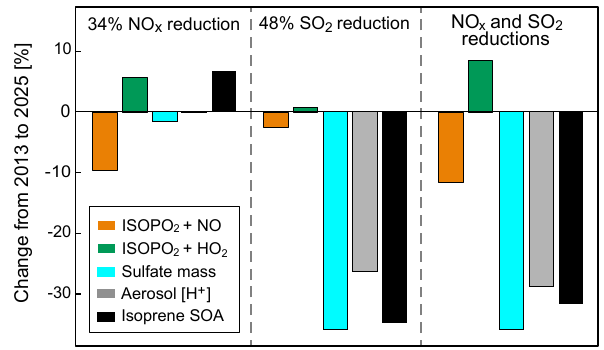
Figure 7. Effect of projected 2013–2025 reductions in US anthro- pogenic emissions on the formation of isoprene secondary organic aerosol (SOA). Emissions of NO x and SO 2 are projected to de- crease by 34 and 48%, respectively. Panels show the resulting per- centage changes in the branching of ISOPO 2 between the NO and HO 2 oxidation channels, sulfate mass concentration, aerosol [H + ] concentration, and isoprene SOA mass concentration. Values are summer means for the southeast US boundary